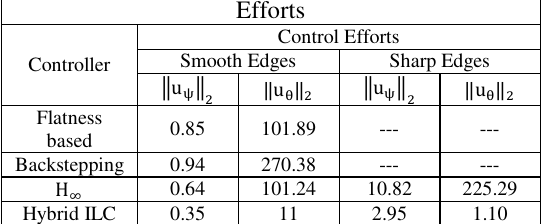
Table 3: Comparison of